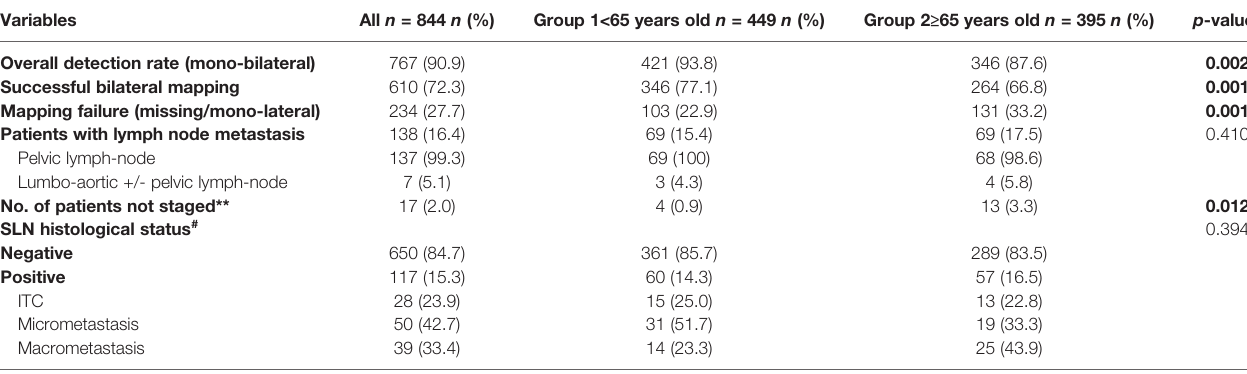
TABLE 2 | SLNs mapping and histopathological fi ndings.